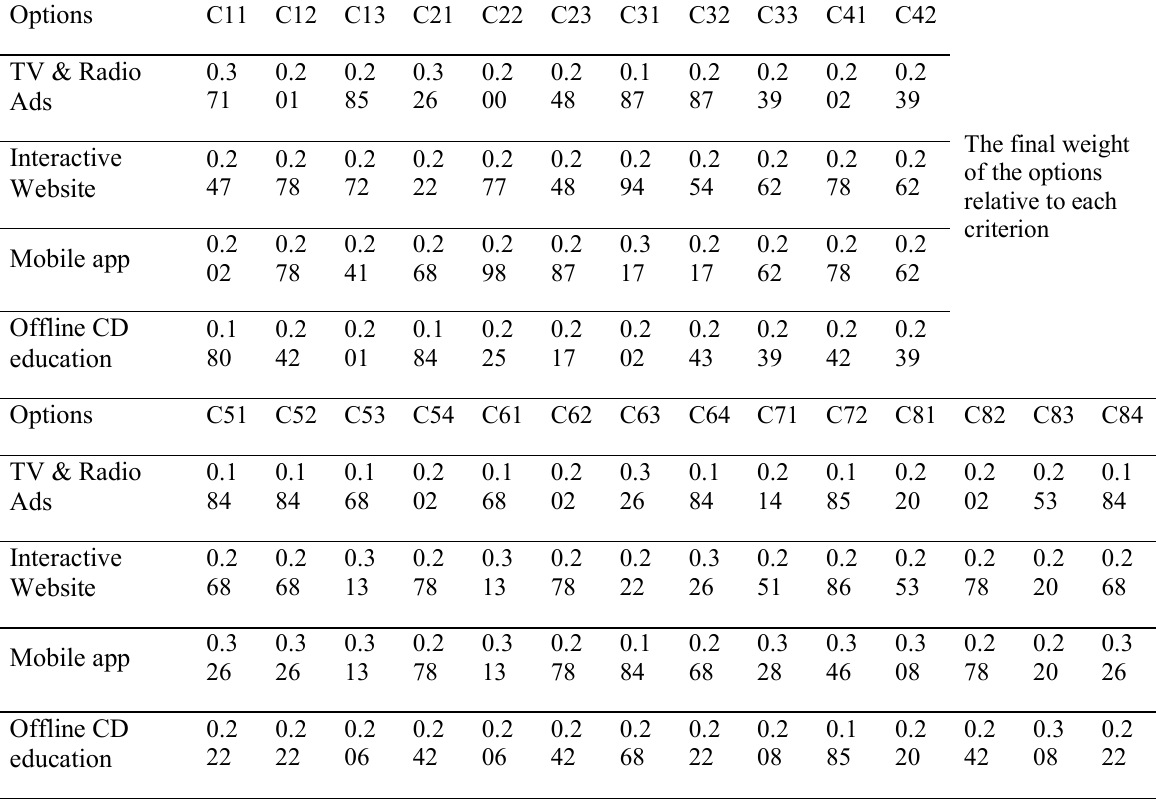
Table 3. Weight of the options relative to each criterion